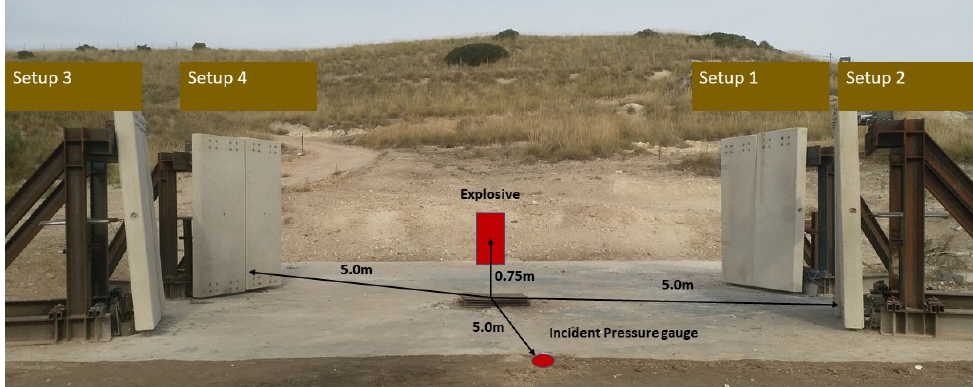
Figure 2. Blast testing infrastructure (setups 1 and 3 are not included in the current